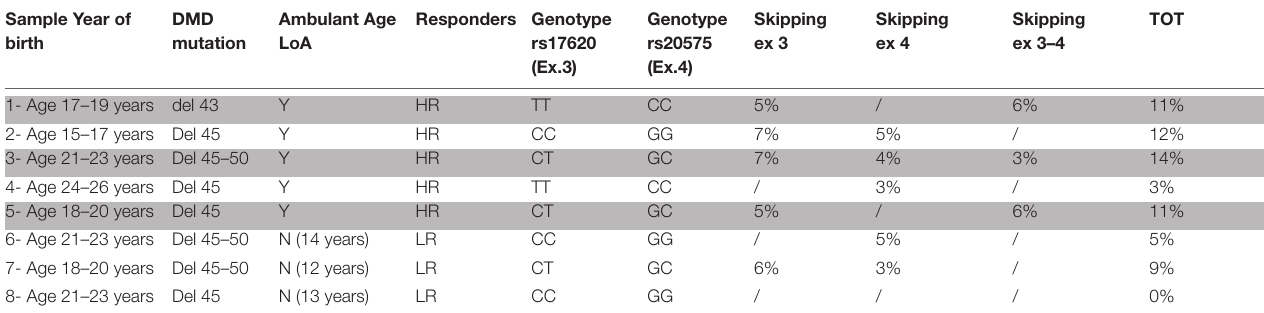
(C) DMD patients muscle biopsies RNA studies to profile the TNFRSF10A exons 3 and 4 skipping propensity. Among these HR patients, the 3 oldest DMD boys (gray label) showed the highest skipping percentages of both exons 3 and